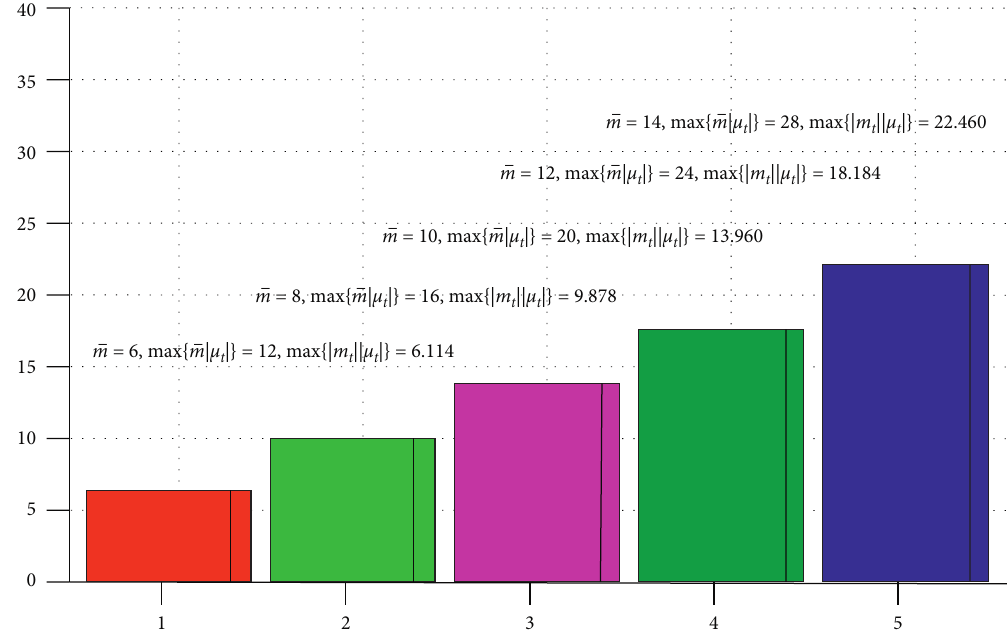
Figure 10: Comparison of the actual control m